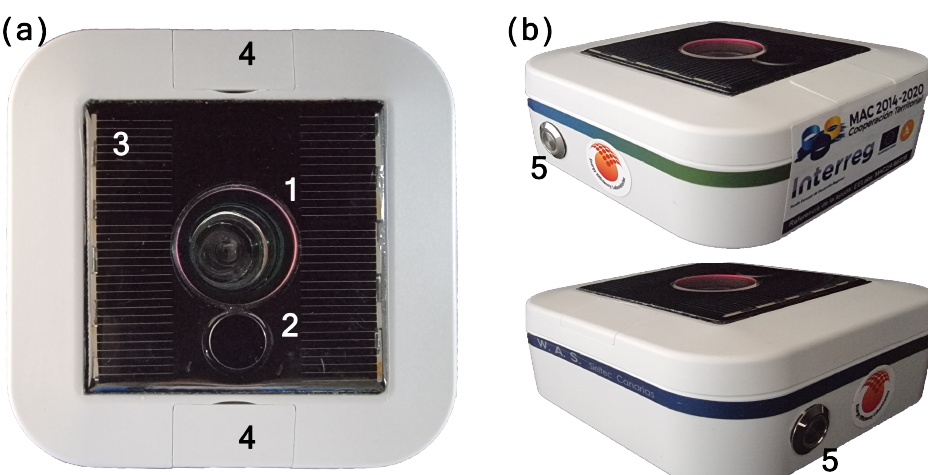
Figure 1. SG-WAS photometer viewed from above ( a ) and two sides ( b ). Its dimensions are 10 cm × 10 cm × 4 cm and it weighs about 100 g. The main elements are sky brightness optics (1), infrared